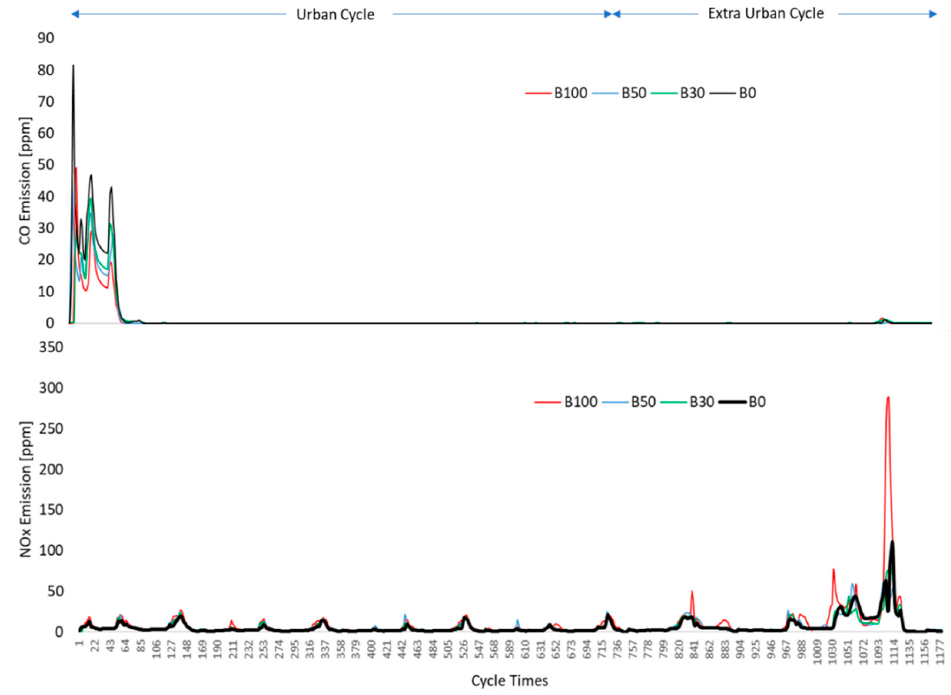
Figure 4. Transient CO and NOx emissions for diesel fuel and biodiesel.